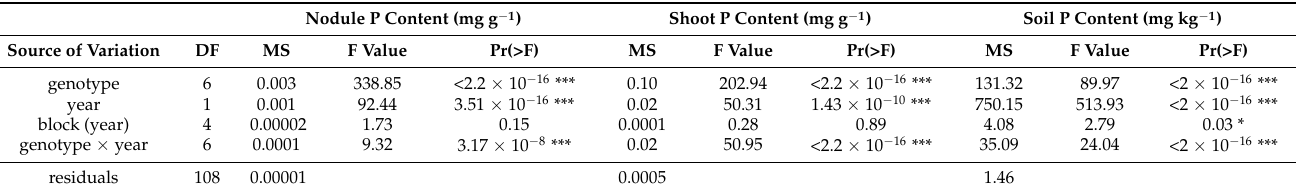
Table 4. Analysis of variance for the phosphorus acquisition of the seven chickpea genotypes grown under a low-P